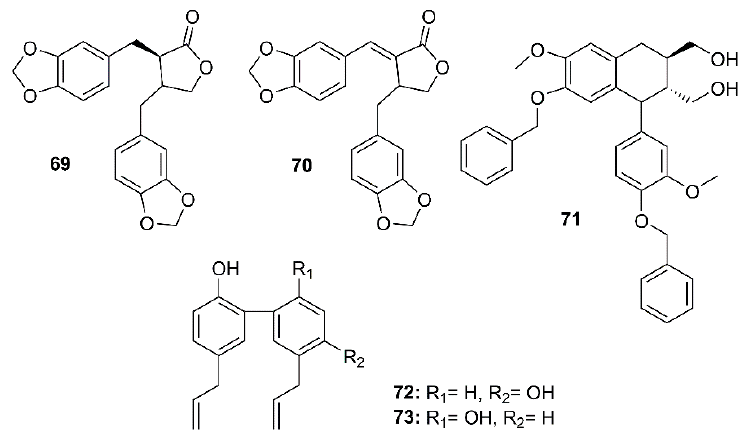
Figure 11. Structures of lignans 69 – 71 and neolignans 72 and 73 .